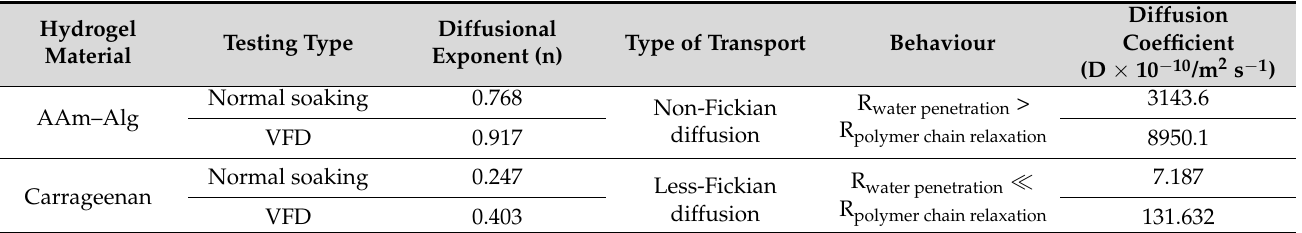
Table 1. Diffusional exponent (n), type of transport, actual behaviours, and diffusion coefficient (D) in normal soaking and VFD testing for hydrogel films of AAm–Alg and